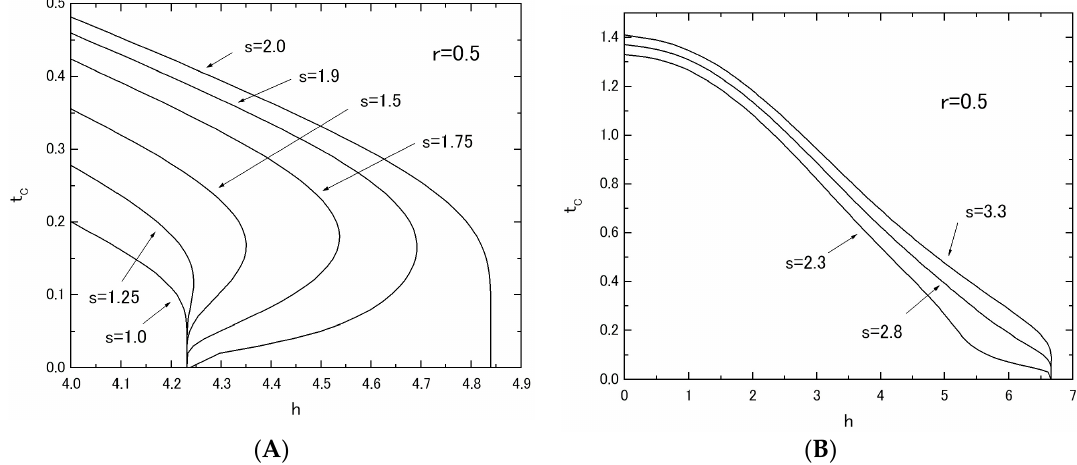
Figure 7. The phase diagrams ( t C versus h plot) for the system B with r = 0 . 5; the value of s is changed from s = 1 . 0 to s = 2 . 0 ( A ). Three values of s are selected as s = 2 . 3, s = 2 . 8 and s = 3 . 3 ( B ).